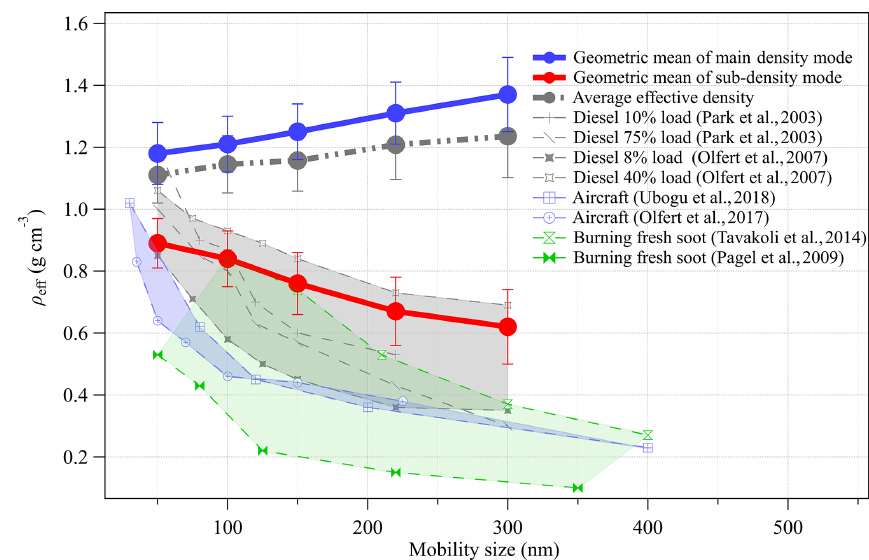
Figure 2. Size dependency of effective density ( ρ eff ) in this study and from selected laboratory experiments for comparison.